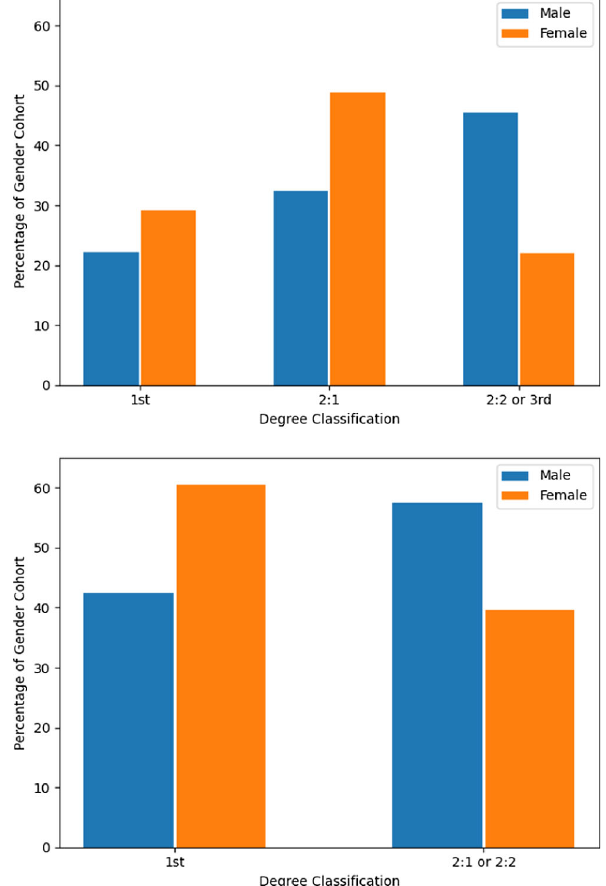
FIG. 2. Proportional split of classifications achieved by stu- dents who exited with (a) a BSc (Hons) ( N ¼ 140 , Male ¼ 99 , Female ¼ 41 ), (b) an MPhys (Hons) ( N ¼ 177 , Male ¼ 134 , Female ¼ 43